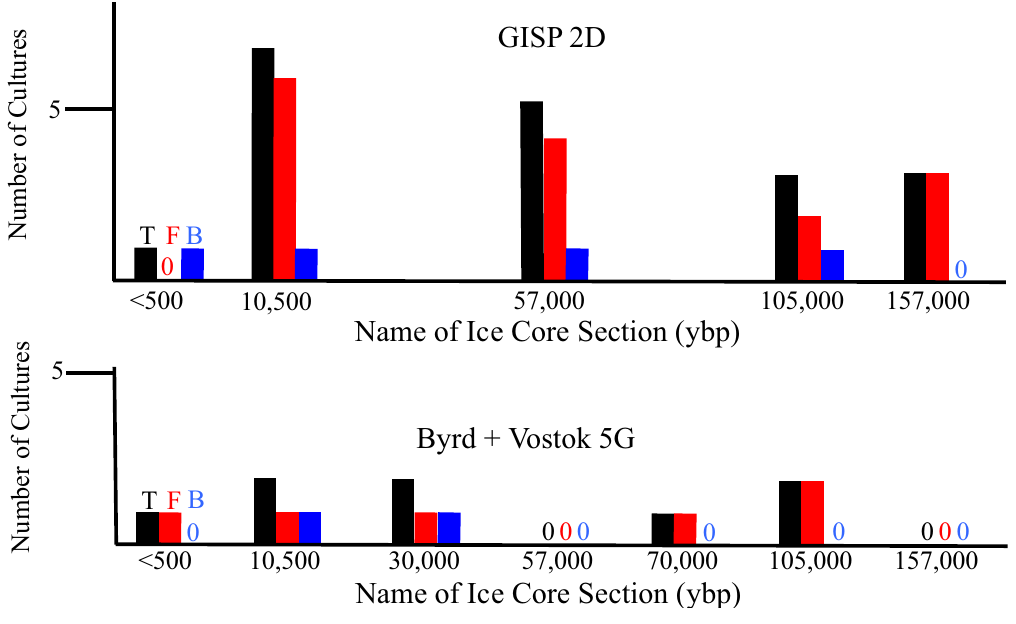
Figure 4. Number of cultures from GISP2D, Byrd and Vostok 5G ice core sections, based on age of ice. Black bars indicate total number of cultures, red bars indicate fungal cultures and blue bars indicate bacterial cultures.